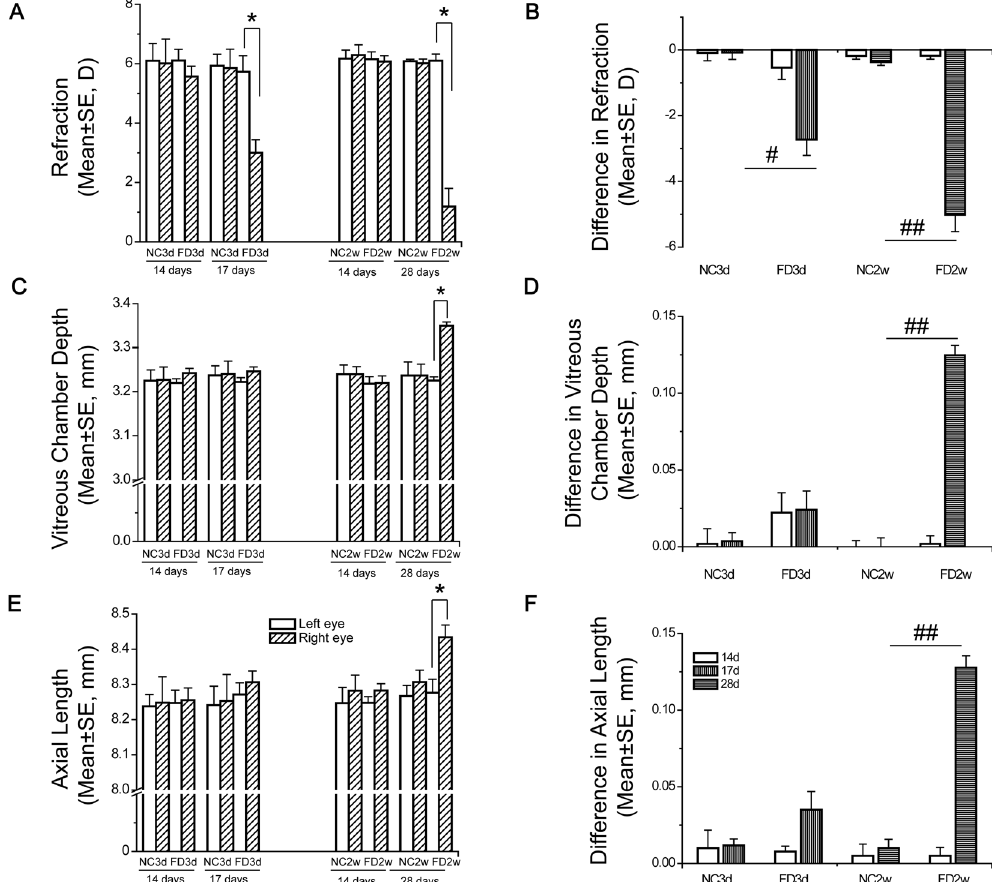
Figure 2. FD induced axial myopia after 2 weeks. Panels (A), C and E show refraction, vitreous chamber depth and axial length of animals in NC3d and FD3d at age of 14 and 17 days, and those of animals in NC2w and FD2w at age of 14 and 28 days. Panels (B,D and F) show differences in refraction, vitreous chamber depth and axial length before and after 3 days of FD for animals in NC3d and FD3d, and differences before and after 14 days of FD for animals in NC2w and FD2w. Sample number: 10 in NC3d, 24 in FD3d, 12 in NC2w, 24 in FD2w. Data are shown as mean ± standard error of the mean(SE). The asterisk in ( A , C and E ) signifies a significant difference between right and left eyes within a group (p < 0.05). Hashtag symbol in ( B , D and F ) designates a significant difference between FD group and respective control group ( # p < 0.05; ## p <